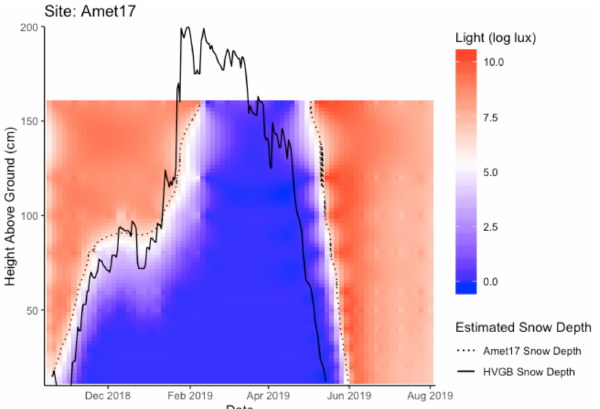
Figure 11. Estimated snow depth at Amet17 site (black dotted line) using interpolated SCLT data overlaid with snow depth measured for winter 2018–2019 at Goose Bay Airport (black solid